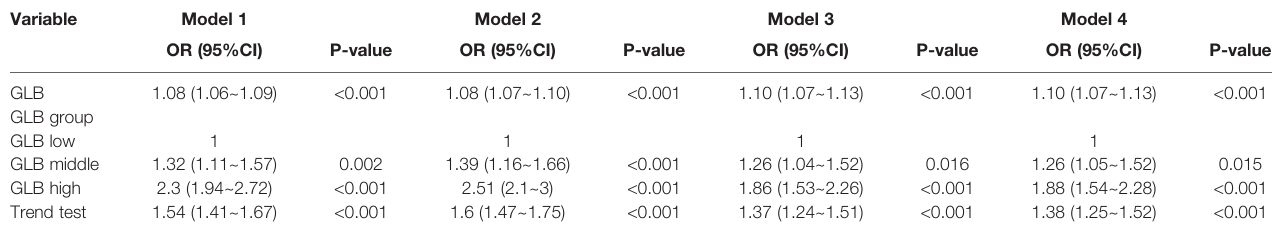
TABLE 3 | Multivariate analysis of association between GLB and diabetic nephropathy.